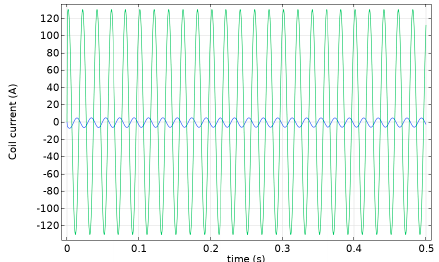
Figure 5. The currents of primary and secondary side under normal conditions.